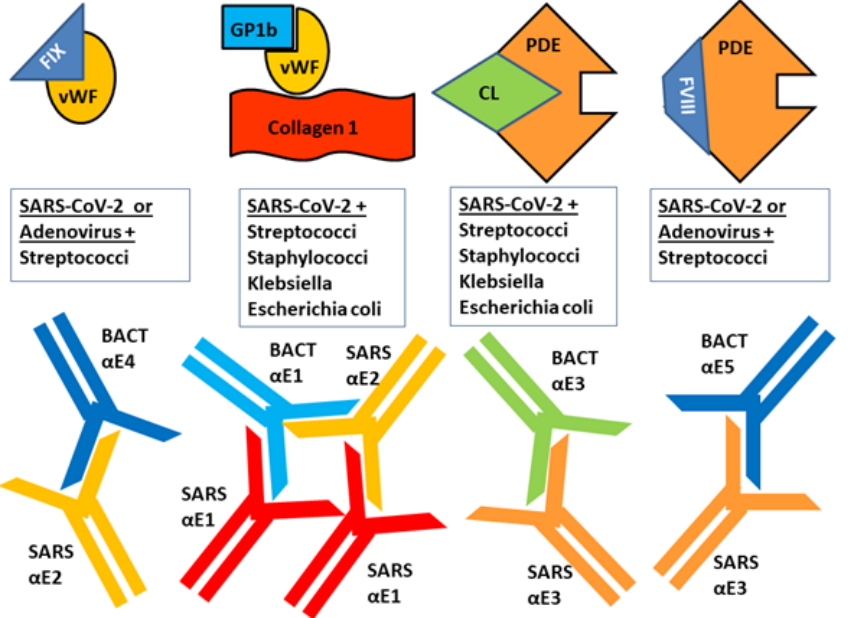
Figure 16. Because many of the blood proteins targeted in COVID-19 coagulopathies are molecularly complementary to each other, they will present complementary epitopes. Microbial antibodies against SARS-CoV-2 epitopes (SARS aE1, SARS aE2, SARS aE3) may then form circulating immune complexes by binding to bacterial antibodies (BACT aE2, BACT aE3, etc.) that can cross-react with the complementary epitope. GP1b = platelet glycoprotein 1b; FVIII = blood coagulation factor VIII. See Figure 16 for other abbreviations.